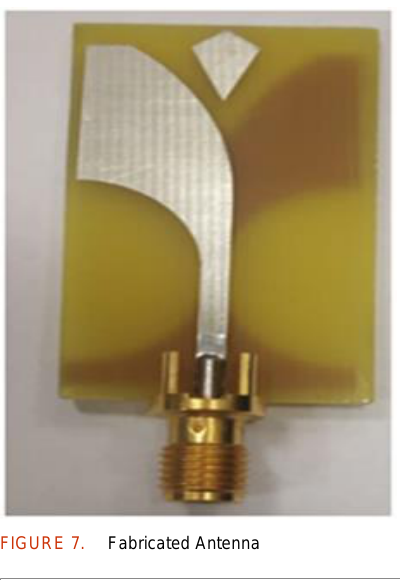
FIGURE 5. Variation of Reflection coefficient with frequency